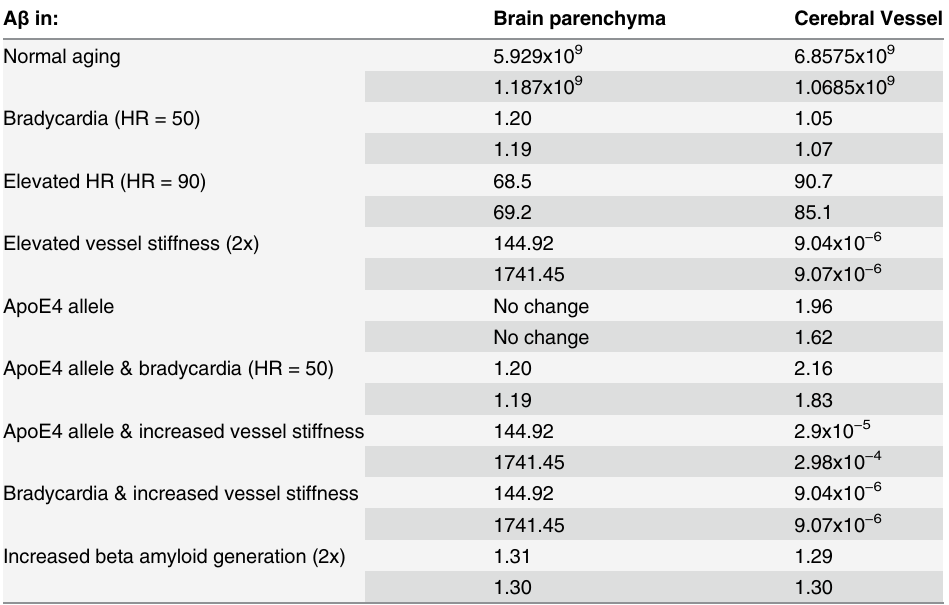
Table 3. Summary of simulation